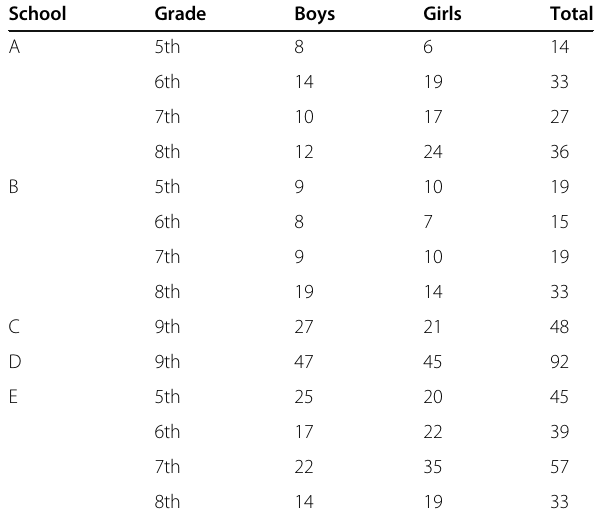
Table 1 Number of participants per grade, school, and gender School